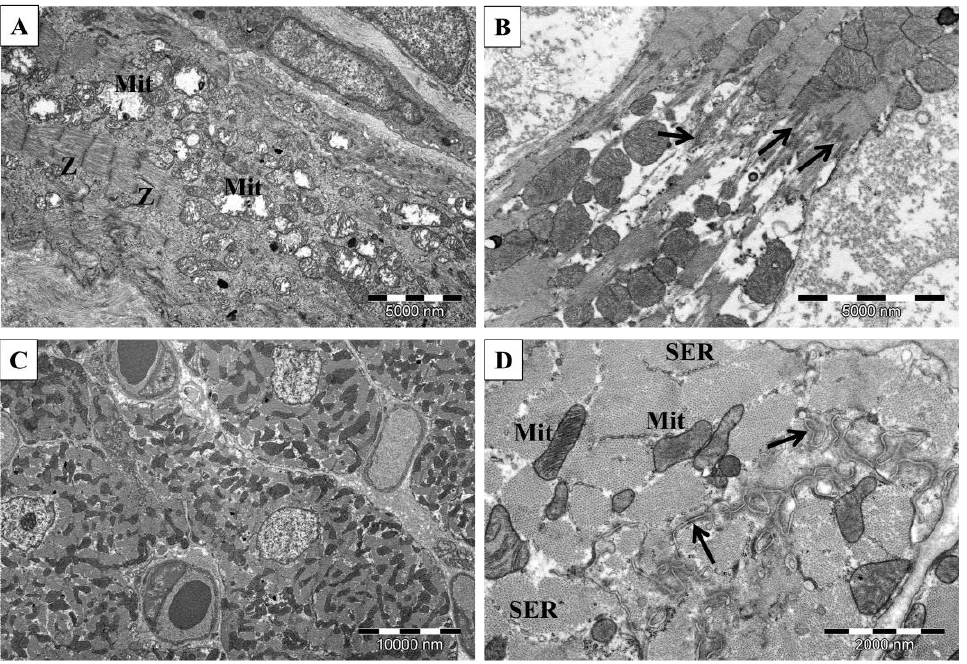
Figure 7. Ultrastructure of the cardiac muscle in rats subjected to EAM (( A , B )—EAM S3; ( C , D )—EAM S30). Swollen mitochondria and substantial loss of myofilaments ( A ), myofilaments connected with the intercalated disc show disarrangement ( B ), normal heart ( C ), the well-organized structure of intercalated disc ( D ). Mit—mitochondria, Z—Z lines, arrows—intercalated disc, SER—sarcoplasmic reticulum. TEM.